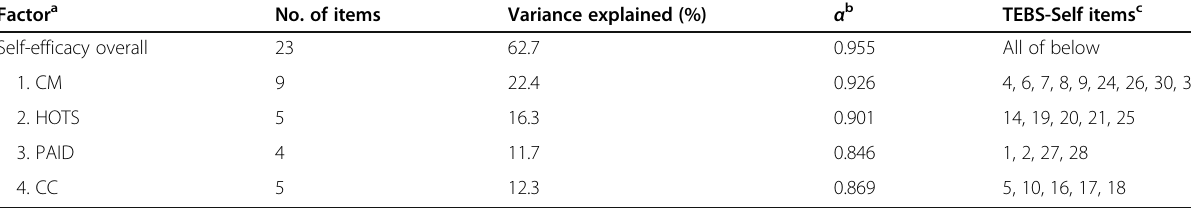
Table 2 Summary of the self-efficacy beliefs exploratory factor analysis Factor a No. of items Variance explained (%) α